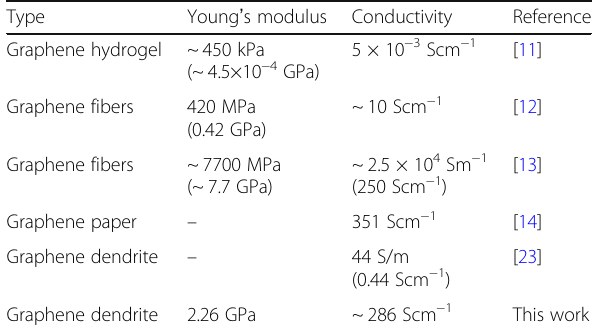
Table 1 The mechanical and electrical properties of different types of graphene-derived materials. This table records Young ’ s modulus and conductivity of different types of graphene- derived materials (graphene hydrogel, graphene fibers, graphene paper, and graphene